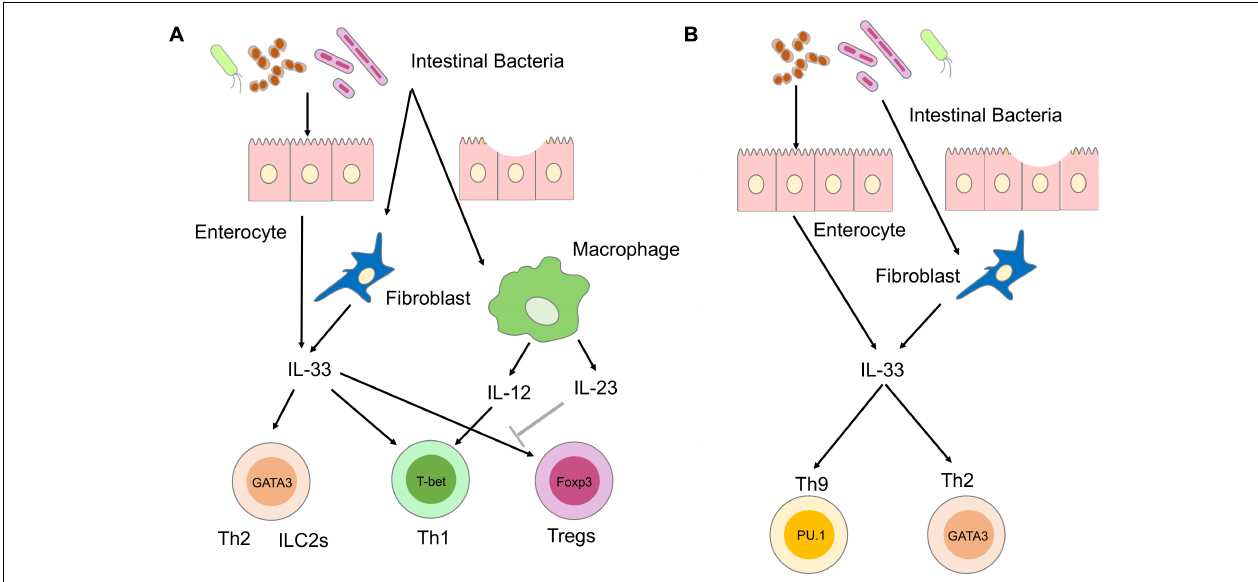
FIGURE 1 | Involvement of IL-33 in the immunopathogenesis of inflammatory bowel diseases (IBD). (A) Involvement of IL-33 in the immunopathogenesis of Crohn’s disease (CD). IL-33 is produced by enterocytes or myofibroblasts upon the disruption of the intestinal barrier and exposure to intestinal microbiota. Sensing of intestinal bacteria by macrophages and dendritic cells (DCs) leads to the production of IL-12 and IL-23. IL-33 and IL-12 synergistically activate T helper type 1 (Th1) cells expressing T-bet. IL-33 promotes Th2 responses mediated by Th2 and group 2 innate lymphoid cells (ILC2s), both expressing GATA3. IL-33 is a potent inducer of regulatory T cells (Tregs) expressing forkhead box p3 (FOXP3), and their responses are restrained by IL-23. (B) Involvement of IL-33 in the immunopathogenesis of ulcerative colitis (UC). IL-33 is produced by enterocytes or myofibroblasts upon disruption of intestinal barrier and exposure to intestinal microbiota. IL-33 activates Th2 and Th9 cells expressing GATA3 and PU.1,